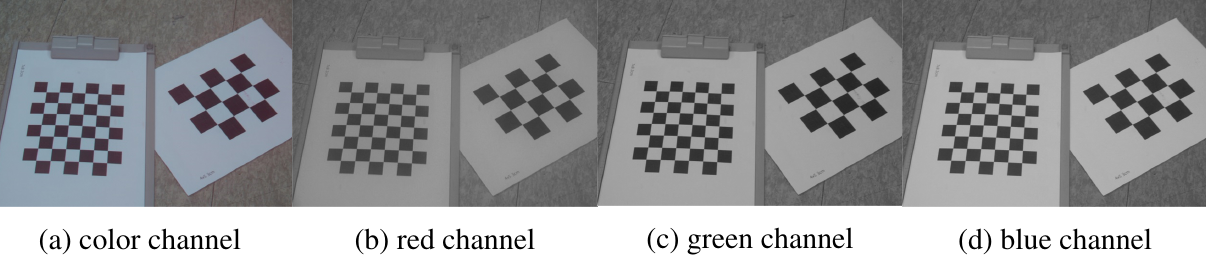
Figure 4. Calibration patterns for estimating the camera parameters. ( a ) Color channel; ( b ) Red channel; ( c ) Green channel; ( d ) Blue